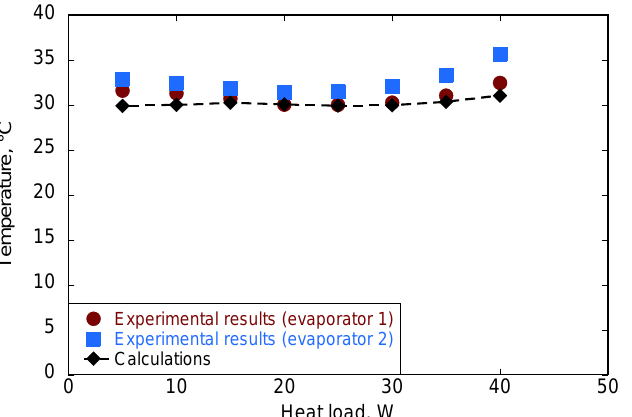
Figure 3. Calculations and experiment results of the two-evaporators type LHP’s each evaporator case’s temperature according to the reference [47] (wick material: polytetrafluoroethylene, working fluid: acetone).